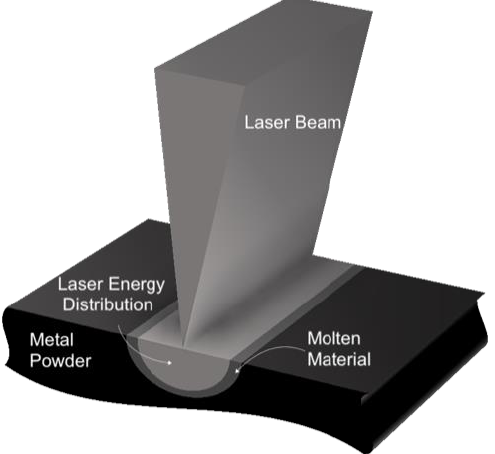
. Q (cid:48) ( W/m ) distributed along the inner surface of the